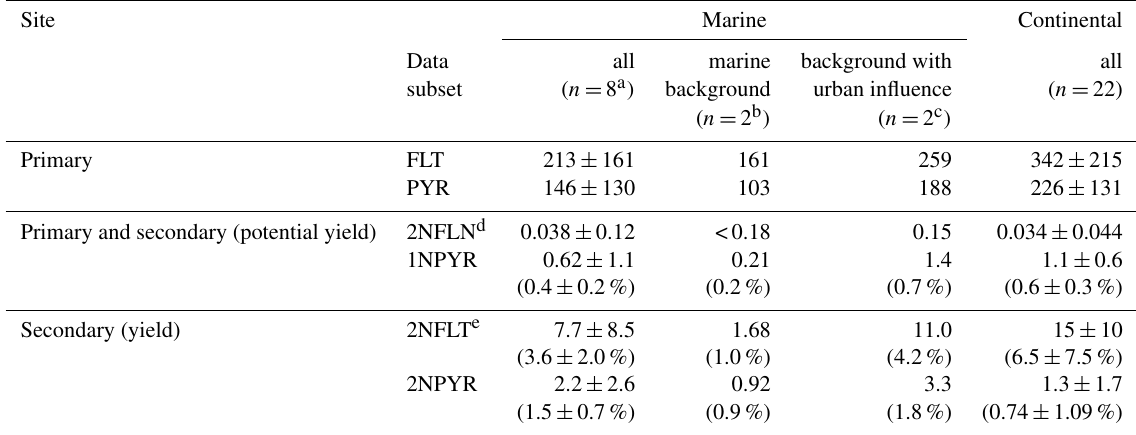
Figure 3. Time-weighted mean (cid:54) 6 4-ring PAH and (cid:54) 11 3–4-ring NPAH mass size distributions (pgm − 3 ) at the marine and continental sites. The error bars show the standard deviation from the campaign mean. Table 4. Selected 4-ring PAHs and primary and secondary 3–4-ring NPAH total (g + p) time-weighted mean concentrations ± σ (pgm − 3 ) . Potential yields, c NPAH /c PAH , in parentheses. σ given for n